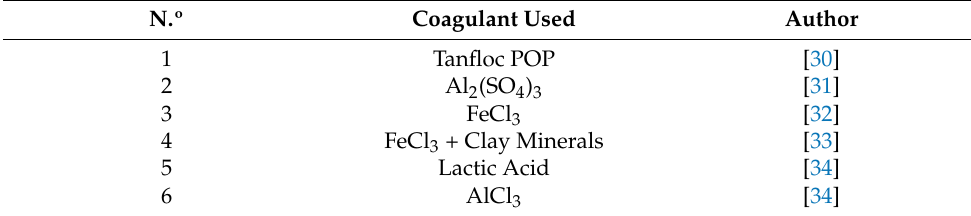
Table 1. Most frequently used coagulants in water treatment according to bibliography.